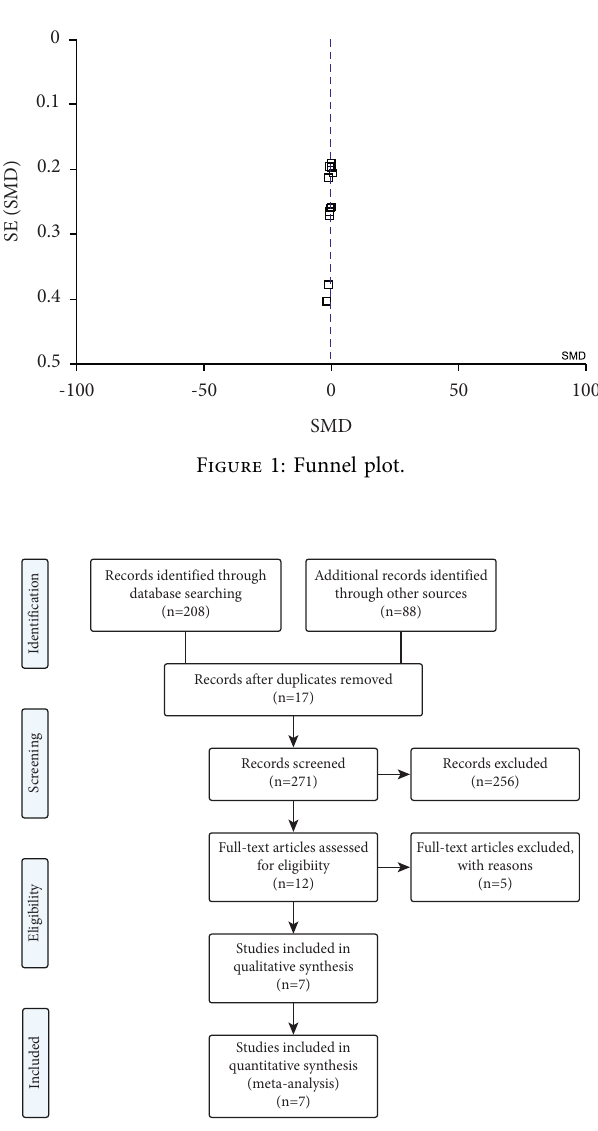
Figure 2: Flow chart of the study